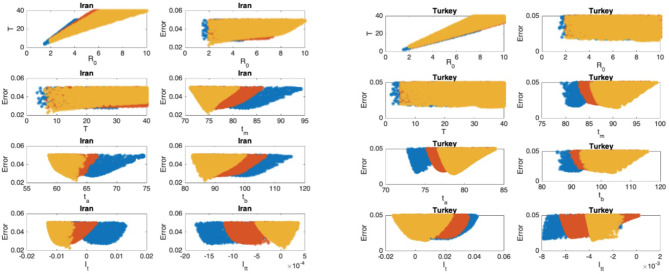
Iran: the 7th and 8th graphs indicate that the epidemic is at the beginning of Phase IV. Turkey: the 7th and 8th graphs indicate that the epidemic is at the end of Phase II.